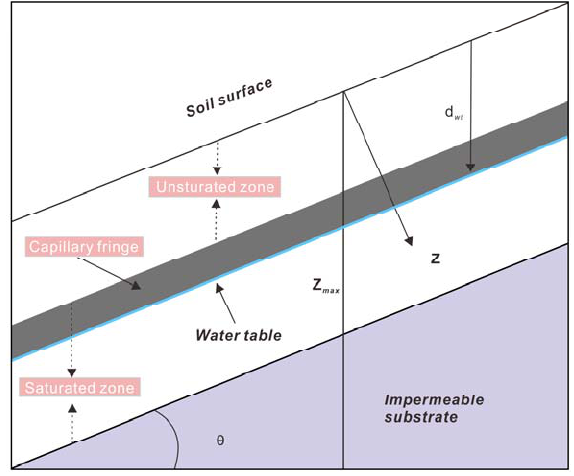
Figure 2. Schematic diagram showing the principle TRIGRS hydrological model (modified from Baum et al. [47]). The initial groundwater table coincides with the bedrock layer. d wt is the thickness of the unsaturated layer, and Z max is the depth of the basal boundary.